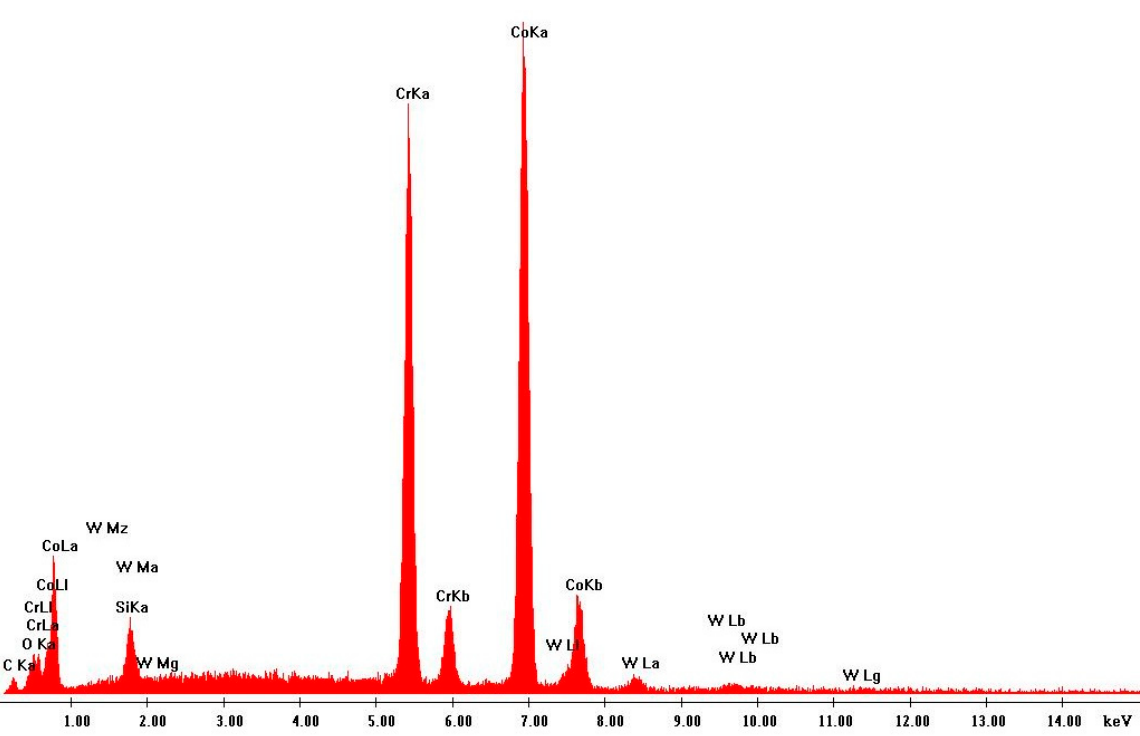
Figure 6. EDS analysis results: Raw Powder 1 (cobalt–chromium–silicon–carbon alloy).